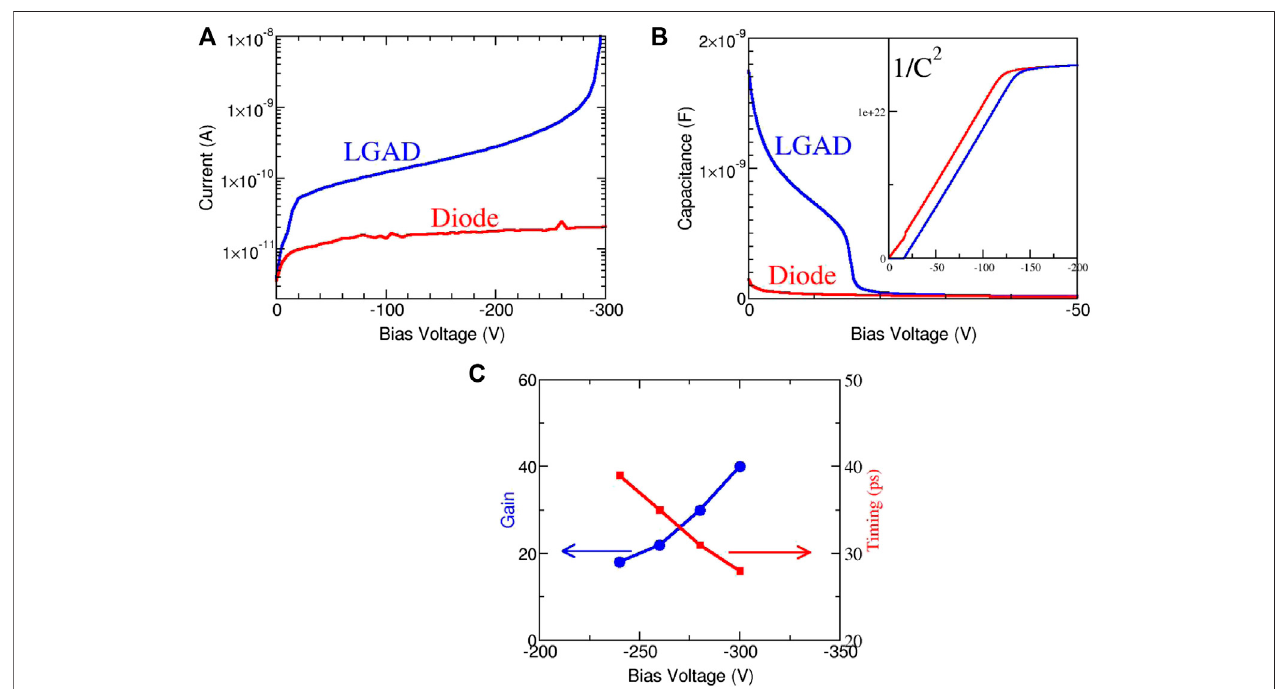
FIGURE4 | Typical plotsobtained during the characterizationofan LGAD (from aBNL production): (A) current vs biasvoltage and (B) capacitance vsbias voltage ofan LGAD and adiode fabricated on thesamewafer;the diodediffersfrom theLGAD for theabsence ofthe gainlayer, which ispresent inthe LGAD.In theinsetof (B) , C - V plotted as C − 2 - V . (C) Gain and timing resolution vs bias voltage for the LGAD of (A) and (B) .